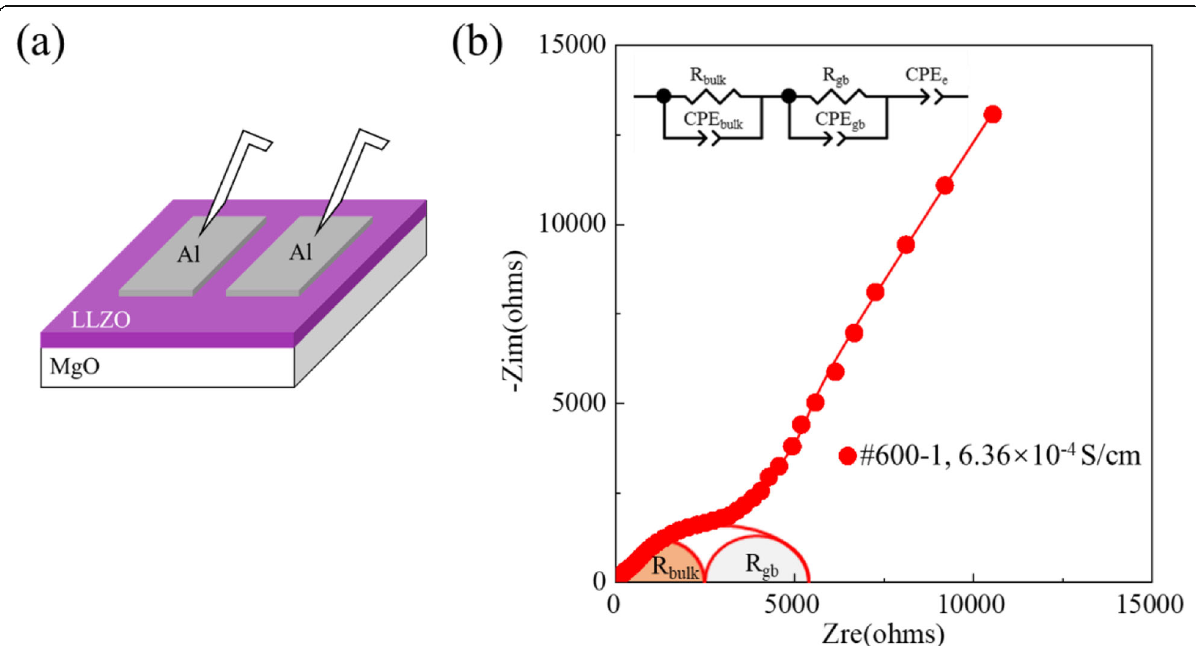
Fig. 6 a The in-plane test configuration for EIS measurements. b The Nyquist plot of impedance spectrum of LLZO thin film #600-1 measured at room temperature, insert shows the equivalent circuit for EIS analysis